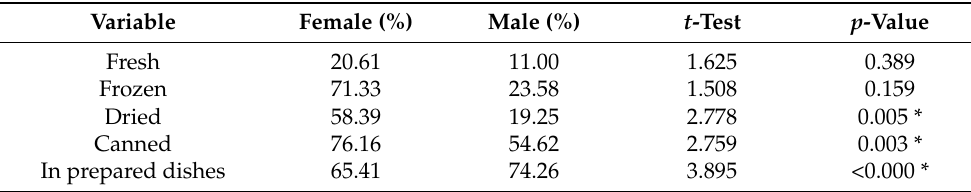
Table 6. The form of pulse products purchased by consumers.